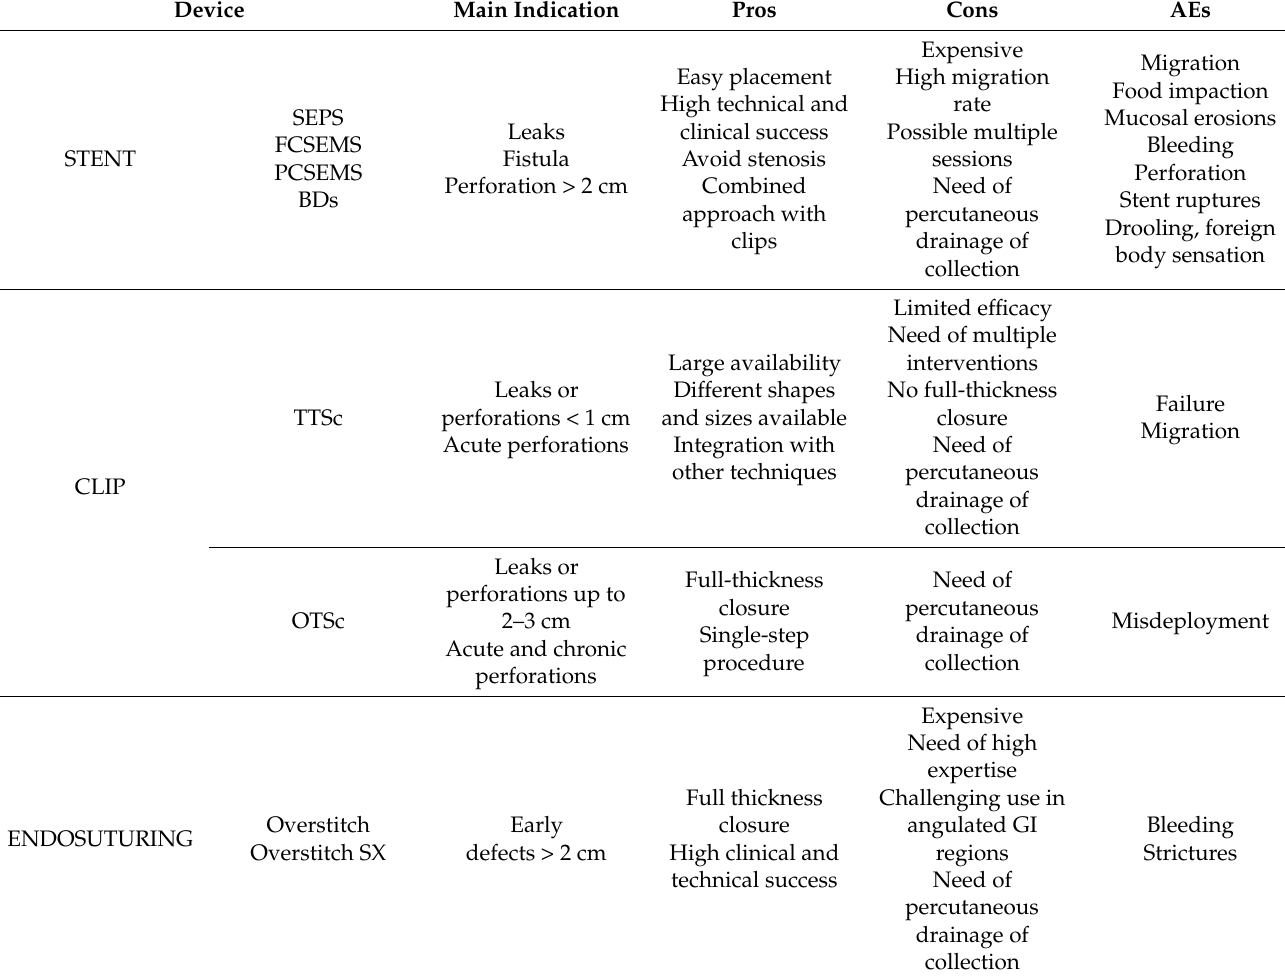
Table 1. Comparison of endoscopic closure techniques of upper GI fistula, leaks and